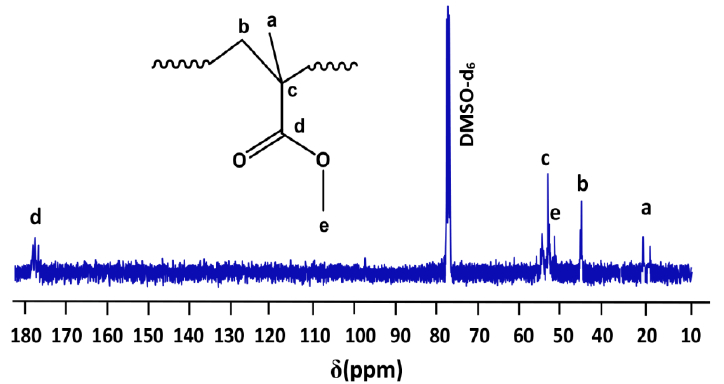
Figure 2. 13 CNMR spectrum of the prepared PMMA.